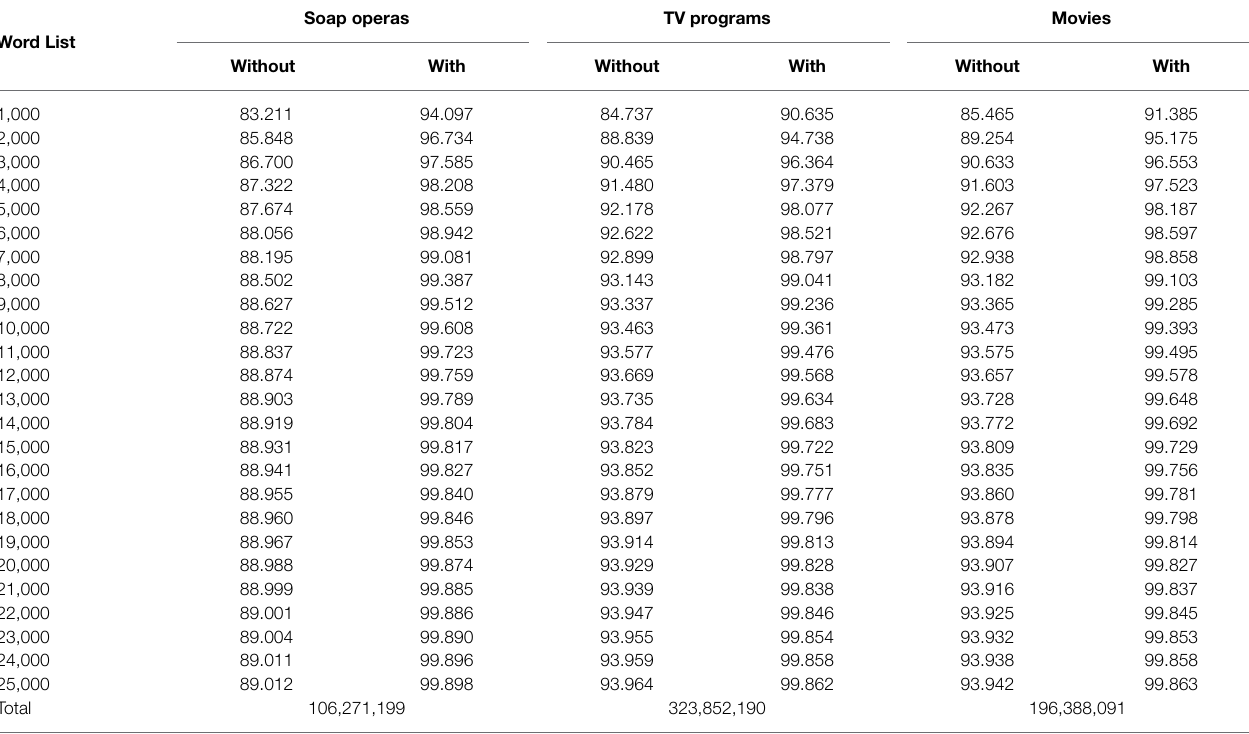
TABLE 4 | Cumulative coverage with and without proper nouns, marginal words, transparent compounds, and acronyms. Soap operas TV programs Movies Word List Without With Without With Without